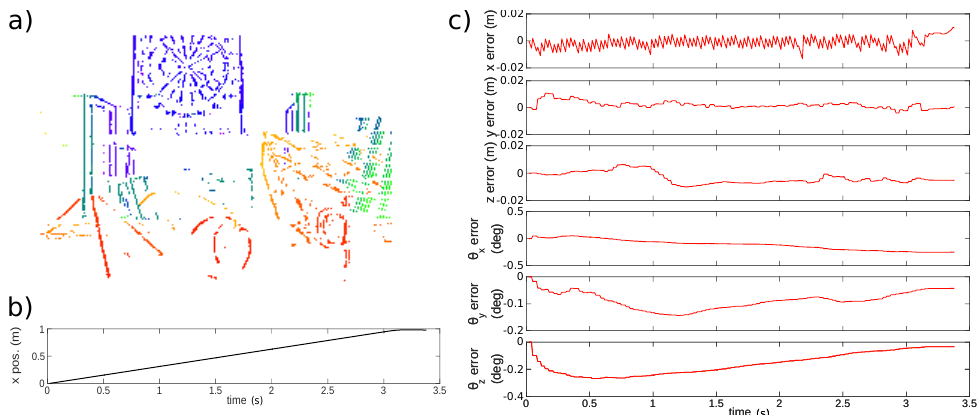
Figure 13. Localization performance on the slider_depth sequence. ( a ) Point cloud generated with EMVS code and example parameters. ( b ) Translation of the sensor along the x -axis while the other degrees of freedom are kept constant. ( c ) Errors of each degree of freedom